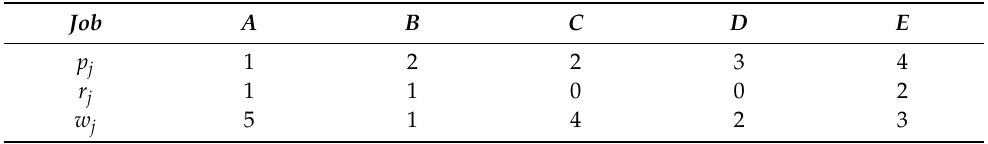
Table 1. Data of the initial